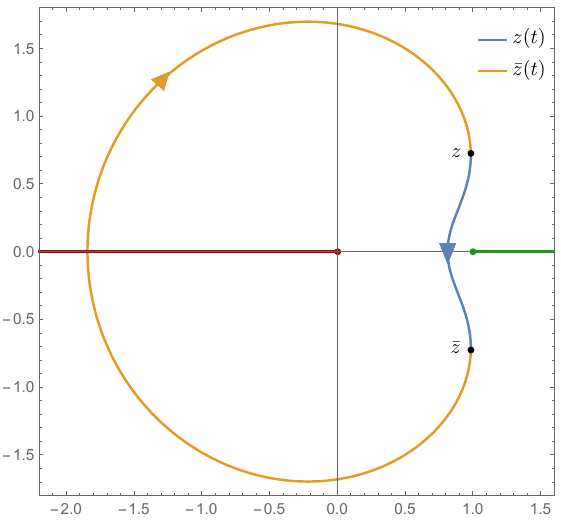
Figure 1 . Paths in the complex plane for the analytic continuation of the variables z and (cid:22) z to the physical region where partons 1 and 2 are